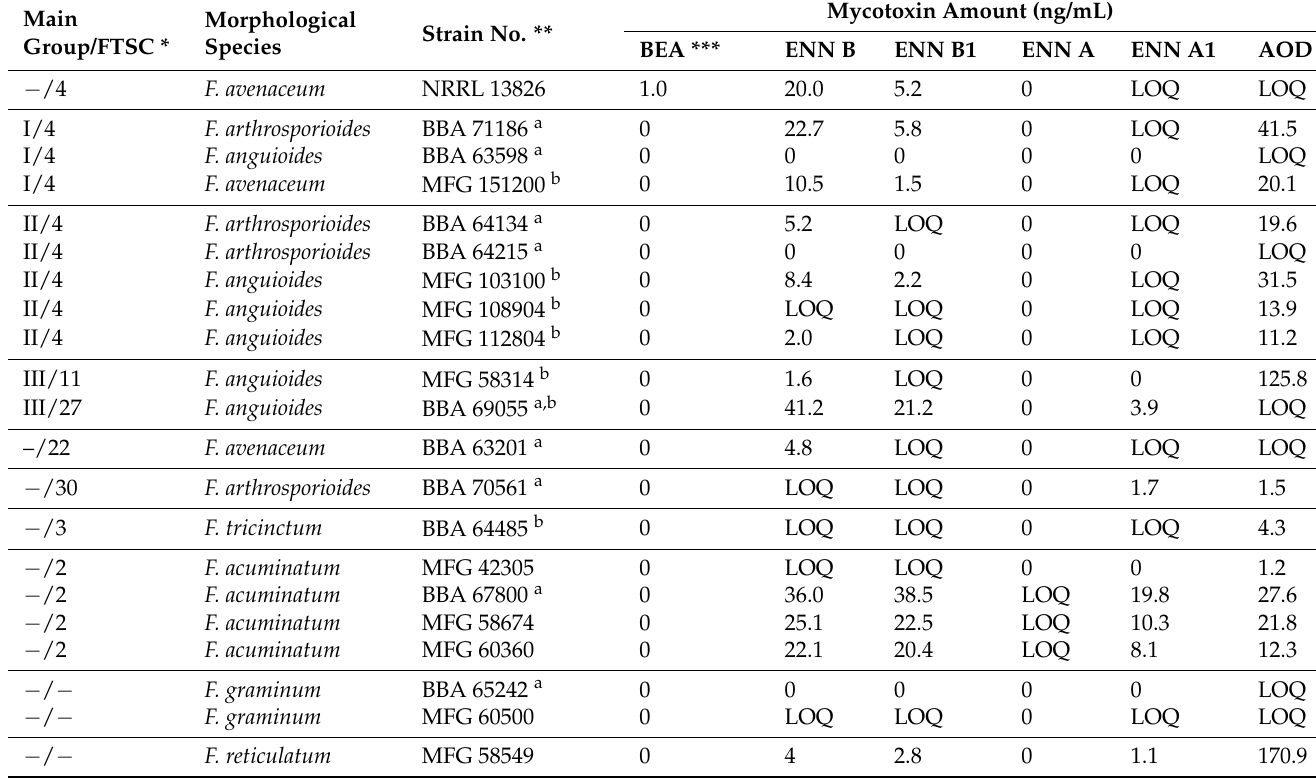
Table 2. Mycotoxins produced by strains of the Fusarium tricinctum species complex compared with F. graminum and F. reticulatum strains on cracked corn